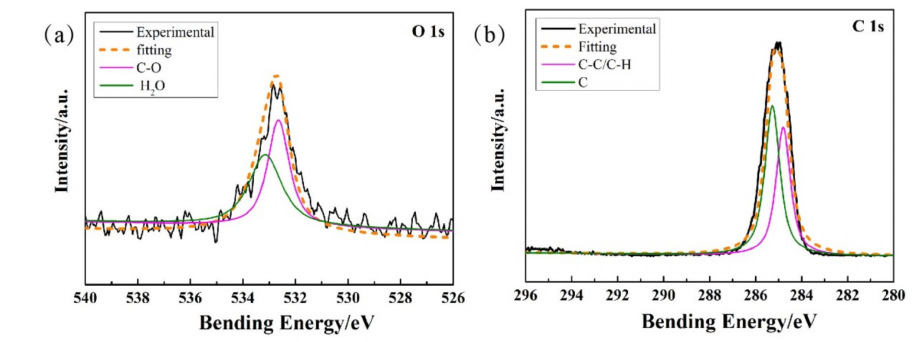
Figure 12. XPS of textured worn plate #3 lubricated by DS ( T = 100 ◦ C): ( a ) Oxygen element; ( b ) Carbon